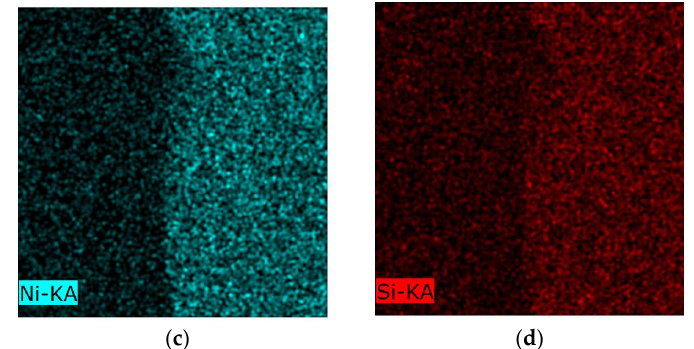
Figure 6. Plane scan results: interface after laser remelting at 500 W: ( a ) Fe-KA; ( b ) Cr-KA; ( c ) Ni-KA; and ( d ) Si-KA.